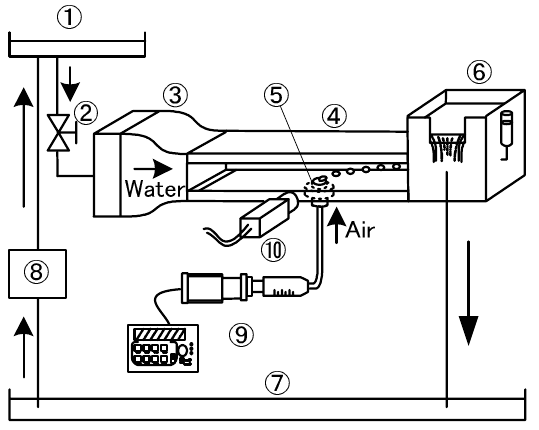
Fig.1 Schematic diagram of the experimental